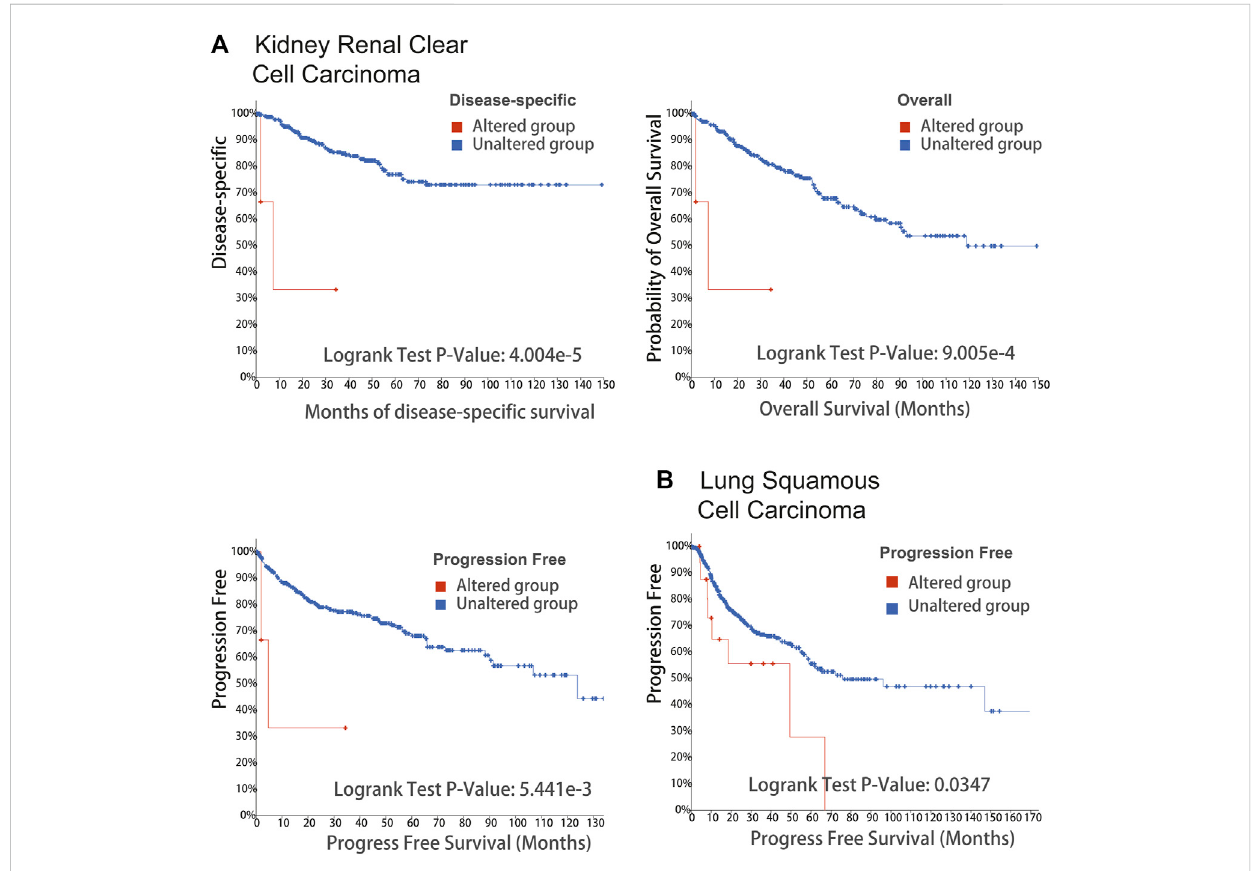
FIGURE 6 Survival analysis of DLD alterations in cancers. The correlation between DLD mutation and prognostic value is shown in (A, B) and was determined using cBioPortal (DSS, DFS, PFS, and OS).